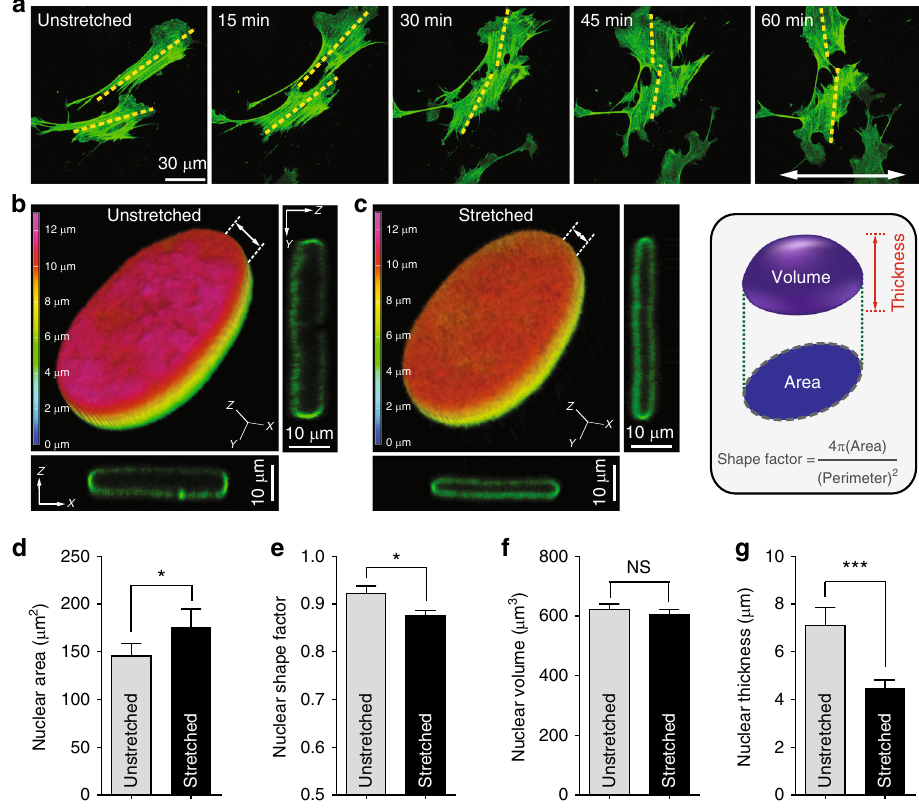
Fig. 1 Stretch-induced nuclear morphological changes in mouse embryonic fi broblasts. a Cell re-orientation under uniaxial cyclic stretching of the substrate. Randomly seeded EGFP – LifeAct-transfected mouse embryonic fi broblasts (MEFs) onto the stretchable PDMS thin fi lm were re-oriented in response to the substrate stretching (8% strain ratio and 1 Hz frequency) by the reorganization of actin cytoskeleton perpendicular to the substrate stretching direction (indicated by white arrow). Yellow dashed lines indicate the main axis of the actin cytoskeleton traversing the cell body. Refer to Supplementary Figure 1 for the veri fi cation of experimental setup. b , c Stretch-induced nuclear fl attening. A GFP – lamin-A-transfected MEF was imaged under the same stretching condition for 1 h. Pseudo-colored z -depth rendering and xz and yz cross-sectional views of the three-dimensionally reconstructed nuclei represent stretch- induced nuclear fl attening. d – g Quanti fi cation of nuclear morphological changes. Footprint size (i.e., area) and shape factor estimated from a projected nuclear morphology onto the XY -plane depict a slight enlargement and elongation of the stretched nuclei ( d , e ). Nuclear volume and thickness (i.e., the maximum length from the basal surface to the apical surface) of the three-dimensionally reconstructed nuclei reveal that substrate stretching generates a pressing force vertical to the nucleus of adherent cells, whereas nuclear volume was conserved ( f , g ). To avoid out-of-focus images and to prevent photobleaching of transfected cells, each image was captured every 15 min for ~1 h ( a ). Overall, > 30 cells were examined per condition ( d – g ), where error bars indicate S.E.M. and statistical differences were calculated using the unpaired t -test, *** p < 0.0001, * p < 0.01, NS not signi fi cant ( p >